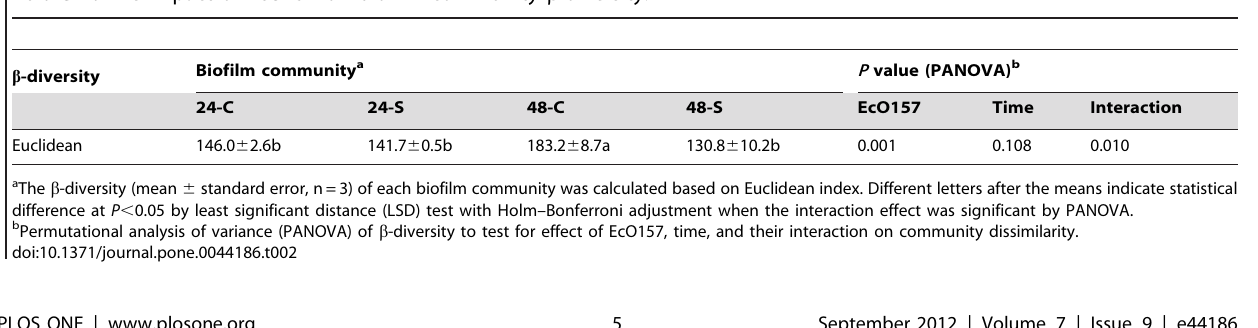
Table 2. The impact of EcO157 on biofilm community b